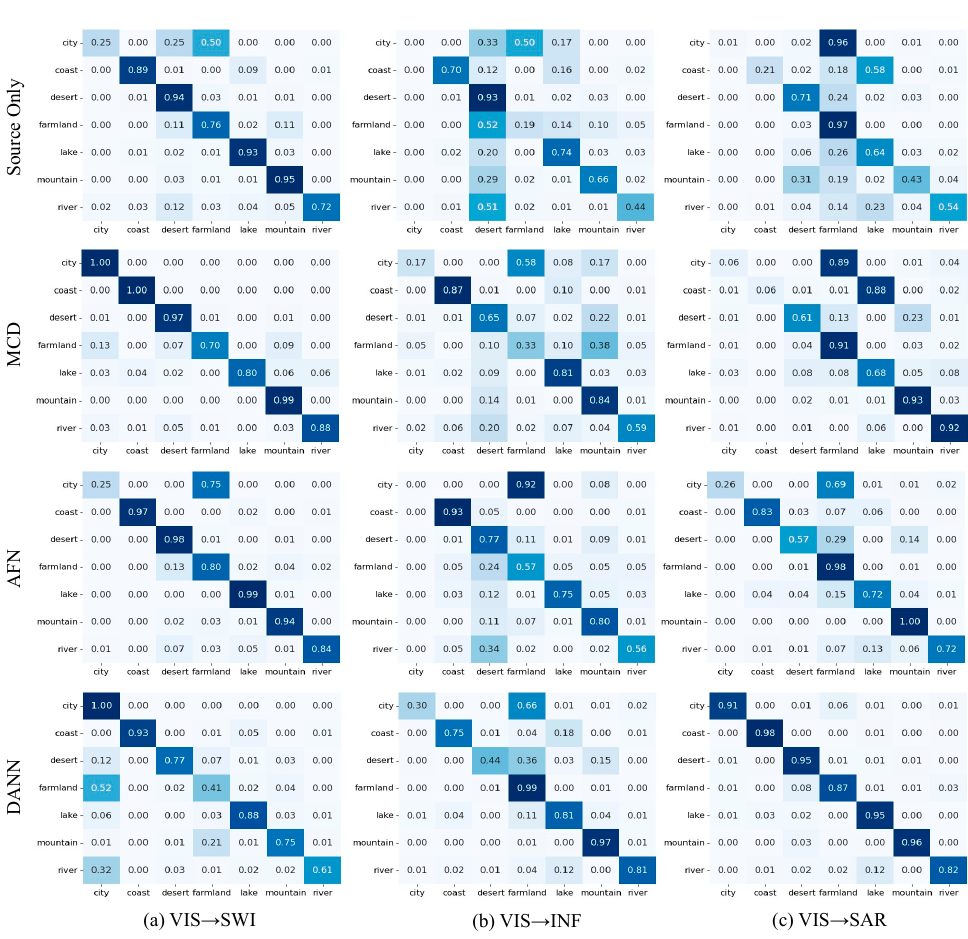
Figure 4. Confusion matrix of obtained by source-only and DA methods on three tasks.